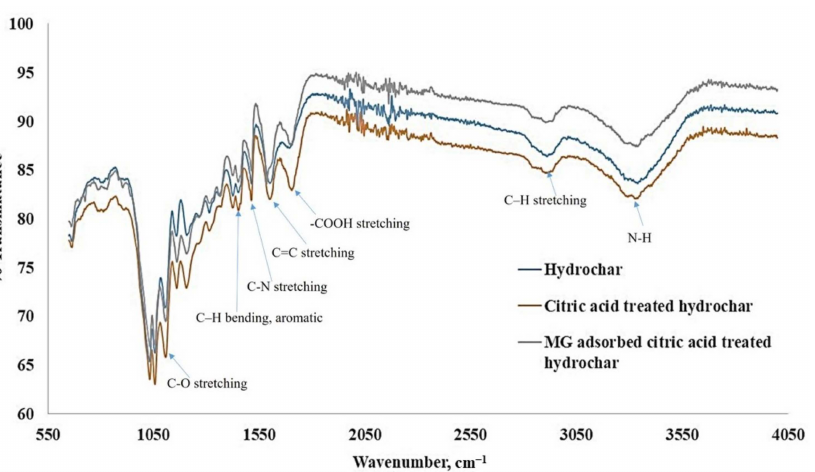
Figure 6. FT spectra of untreated wood apple hydrochar, citric acid treated wood apple hydrochar and MG adsorbed citric acid treated